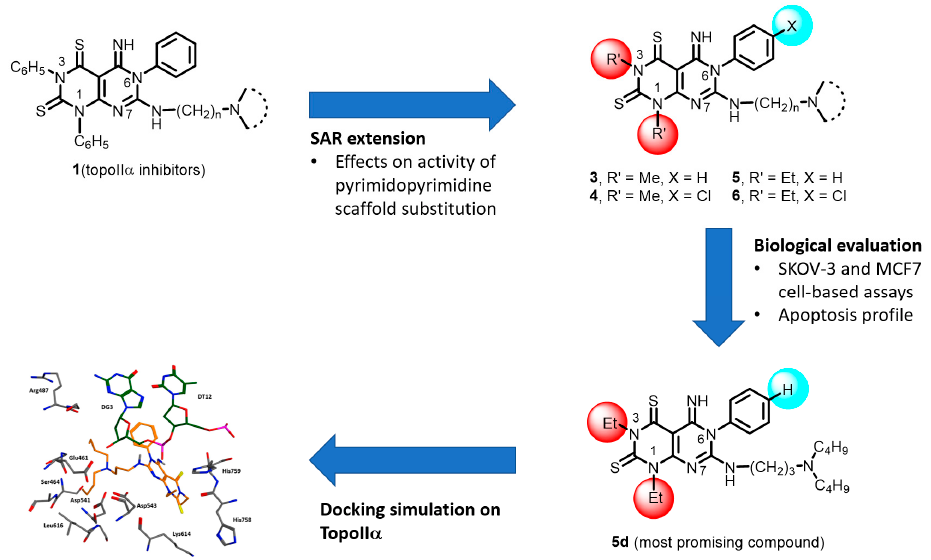
Figure 5. Design, synthesis, biological evaluation and docking simulation of new pyrimido-pyrimidine 3 – 6 . Supplementary Materials: Figure S1: 1 H-NMR (200 MHz, d 6 -DMSO) spectrum of compound 7 , Figure S2: 13 C-NMR (101 MHz, d 6 -DMSO) spectrum of compound 7 , Figure S3 : IR (KBr) spectrum of compound 7 , Figure S4: Mass spectrum of compound 7 , Figure S5: 1 H-NMR (200 MHz, d 6 -DMSO) spectrum of compound 8 , Figure S6: 13 C-NMR (101 MHz, d 6 -DMSO) spectrum of compound 8 , Figure S7: IR (KBr) spectrum of compound 8 , Figure S8: Mass spectrum of compound 8 , Figure S9: 1 H-NMR (200 MHz, CDCl 13 C-NMR (101 MHz, CDCl 3 ) spectrum of compound 9 , Figure S10: 3 ) spectrum of compound 9 , Figure S11: IR (KBr) spectrum of compound 9 , Figure S12: Mass spectrum of compound 9 , Figure S13: 1 H-NMR (200 MHz, CDCl 3 ) spectrum of compound 10 , Figure S14: 13 C-NMR (101 MHz, CDCl 3 ) spectrum of compound 10 , Figure S15: IR (KBr) spectrum of compound 10 , Figure S16: Mass spectrum of compound 10 , Figure S17: 1 H-NMR (300 MHz, d 6 -DMSO) spectrum of compound 11 , Figure S18: 13 C-NMR (75 MHz, d 6 -DMSO) spectrum of compound 11 , Figure S19: IR (KBr) spectrum of compound 11 , Figure S20: Mass spectrum of compound 11 , Figure S21: 1 H-NMR (200 MHz, CDCl 3 ) spectrum of compound 12 , Figure S22: 13 C-NMR (101 MHz, CDCl 3 ) spectrum of compound 12 , Figure S23: IR (KBr) spectrum of compound 12 , Figure S24: Mass spectrum of compound 12 , Figure S25: 1 H-NMR (200 MHz, CDCl 3 ) spectrum of compound 3a , Figure S26: 13 C- NMR (101 MHz, CDCl 3 ) spectrum of compound 3a , Figure S27: IR (KBr) spectrum of compound 3a , Figure S28: Mass spectrum of compound 3a , Figure S29: 1 H-NMR (200 MHz, CDCl 3 ) spectrum of compound 3b , Figure S30: 13 C-NMR (101 MHz, CDCl 3 ) spectrum of compound 3b , Figure S31: IR (KBr) spectrum of compound 3b , Figure S32: 1 H-NMR (200 MHz, CDCl 3 ) spectrum of compound 3c , Figure S33: 13 C-NMR (101 MHz, CDCl 3 ) spectrum of compound 3c , Figure S34: IR (KBr) spectrum of compound 3c , Figure S35: 1 H-NMR (200 MHz, CDCl 3 ) spectrum of compound 3d , Figure S36: 13 C-NMR (101 MHz, CDCl 3 ) spectrum of compound 3d , Figure S37: IR (KBr) spectrum of compound 3d , Figure S38: 1 H-NMR (200 MHz, CDCl 3 ) spectrum of compound 3e , Figure S39: 13 C-NMR (101 MHz, CDCl 3 ) spectrum of compound 3e , Figure S40: IR (KBr) spectrum of compound 3e , Figure S41: 1 H-NMR (200 MHz, CDCl 3 ) spectrum of compound 4a , Figure S42: 13 C-NMR (101 MHz, CDCl 3 ) spectrum of compound 4a , Figure S43: IR (KBr) spectrum of compound 4a , Figure S44: 1 H-NMR (200 MHz, CDCl 13 C-NMR (101 MHz, CDCl 3 ) spectrum of compound 4b , Figure S45: 3 ) spectrum of compound 4b , Figure S46: IR (KBr) spectrum of compound 4b , Figure S47: 1 H-NMR (200 MHz, CDCl 3 ) spectrum of compound 4c , Figure S48: 13 C-NMR (101 MHz, CDCl 3 ) spectrum of compound 4c, Figure S49: IR (KBr) spectrum of compound 4c , Figure S50: 1 H-NMR (200 MHz, CDCl 3 ) spectrum of compound 4d , Figure S51: 13 C-NMR (101 MHz, CDCl 3 ) spectrum of compound 4d , Figure S52: IR (KBr) spectrum of compound 4d , Figure S53: 1 H-NMR (200 MHz, CDCl 3 )